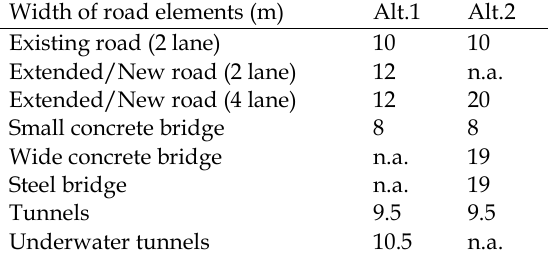
Table 2. Summary of road widths for each Oslo fjord crossing alternative Width of road elements